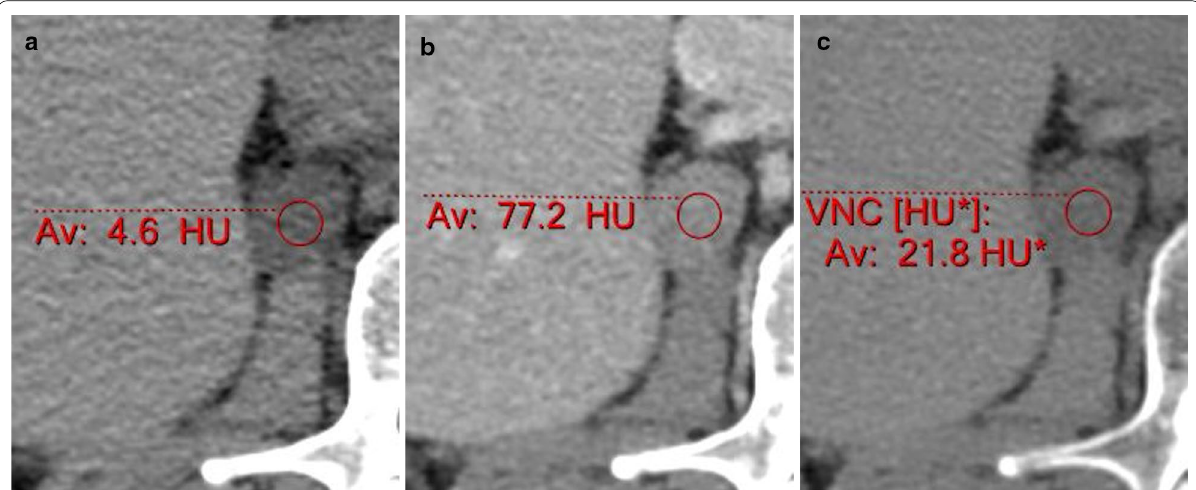
Fig. 2 Adrenal CT of a 52-year-old woman showing a 21 mm nodule in the right adrenal gland. The nodule has an attenuation of 4.6 HU on TNC images ( a ), 77.2 HU on portovenous phase images ( b ) and 27 HU on 15 min delayed images (not shown), proving this is adenoma both by showing an absolute washout of 69% and by pre-contrast attenuation. However, VNC images show attenuation of 21.8 HU ( c ), making this an indeterminate nodule had this been an incidentaloma on portovenous phase spectral imaging